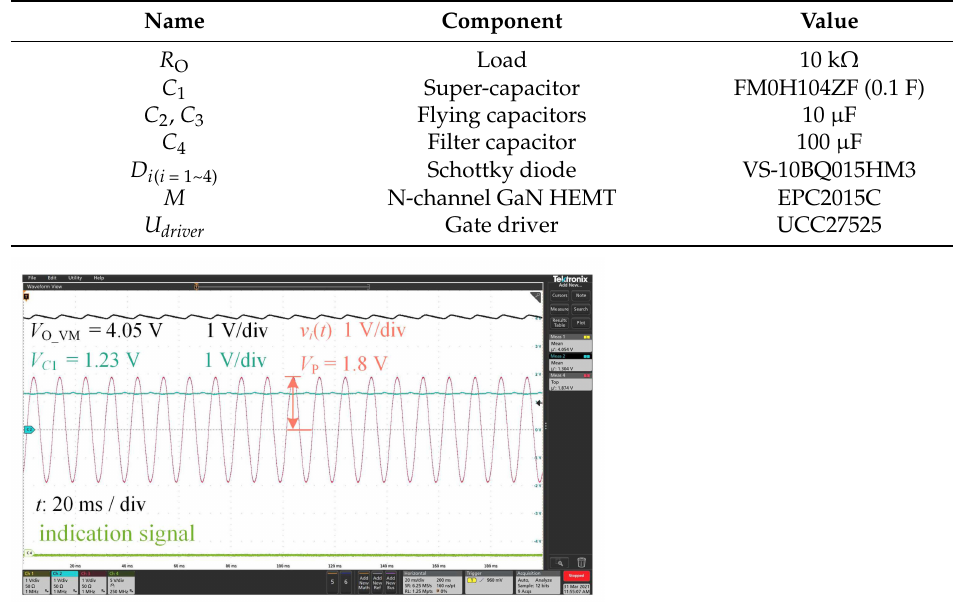
Table 2. The key components used in this design.